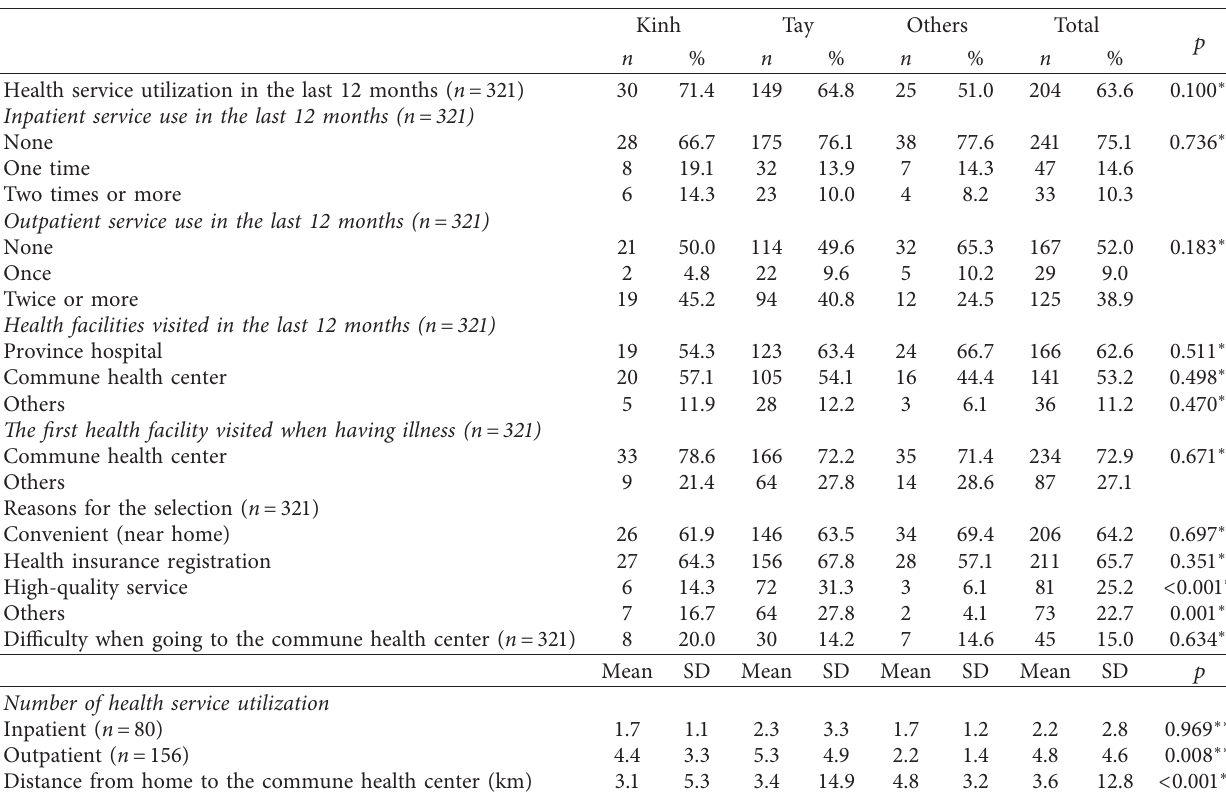
Table 3: Characteristics of use and access to health services.